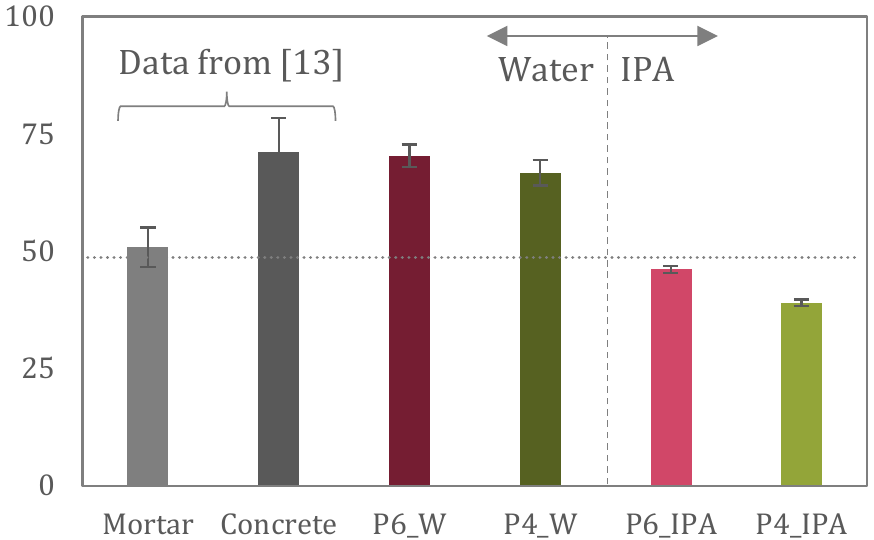
Figure 12. Primary horizontal deformation values relative to strain values at 28 days of exposure for pastes (tested with water and IPA, data from this study), and mortar and concrete (tested with water data from [13]).